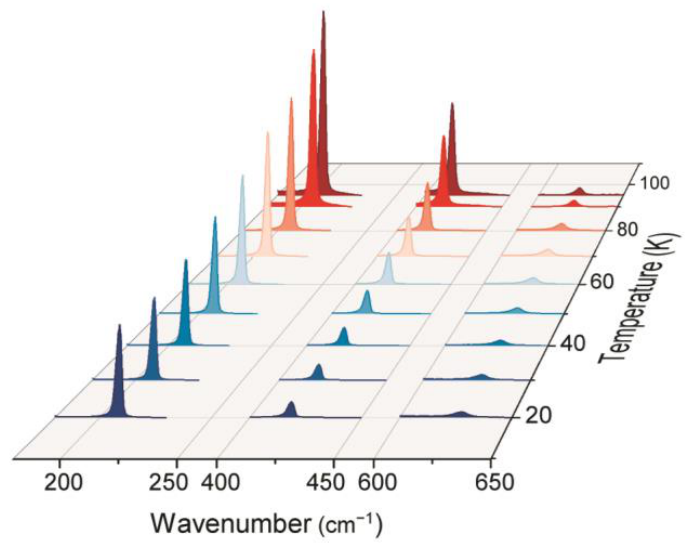
Figure 1. Raman spectra of the ZnTe film measured in the temperature range of 20 – 100 K. Careful analysis of thermally induced change of ZnTe Raman spectra shows that ratiometric technique between different observed vibrational lines can provide contactless temperature sensing. For example, the intensity ratio between 1LO and 2LO intensities (R 12 ) can be utilized as a temperature-dependent parameter for optical thermometry. The experimental values of R 12 as a function of temperature are presented in Figure 2a. The observed R 12 temperature dependence can be accurately fitted by a pseudo-linear function with suitable quality Adj. R 2 = 0.98, which facilitates defining temperature from the calculated ratio. Another temperature-sensitive parameter proposed is the intensity ratio between 3LO and 2LO lines—R 32 . Similar to the former case, R 32 experimental values were approximated with a linear function with slightly worse quality. Both ratiometric approaches prove the possibility of using Raman spectra of ZnTe for optical thermal sensing. However, R 12 provides thermometry within the temperature range of 20–100 K, whereas R 32 allows thermal sensing in the region of 20–95 K. This fact could be explained by an indistinguishable intensity of the 3LO mode at 100